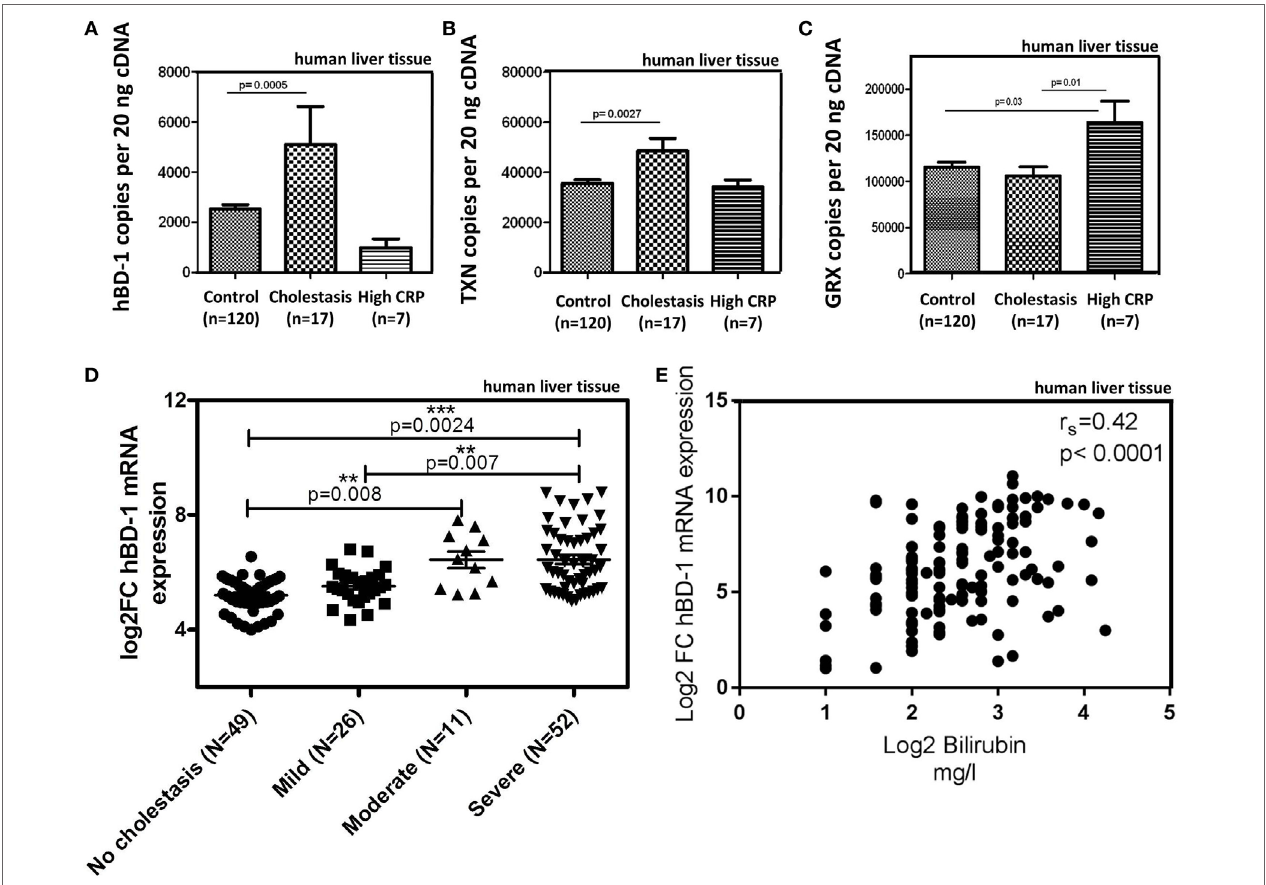
FigUre 3 | hBD-1 expression in samples of patients with cholestasis. (a–c) mRNA expression of hBD-1 (a) and human oxidoreductases TXN (B) and GRX (c) were analyzed in human liver tissue ( n = 144). Control group ( n = 120) without cholestasis was compared with cholestatic samples (serum bilirubin > 1.2 mg/dl, mean 4.5 mg/dl) and samples with signs of systemic inflammatory response (CRP > 5 mg/l). mRNA transcript levels are measured in an amount of 20 ng cDNA. Total copy numbers are depicted. Data are presented as means ± SEM. Values between groups were considered statistically significant with p < 0.05. (D) Hepatic hBD-1 mRNA expression was assessed in a cohort of patients with different grades of cholestasis ( n = 138). Depicted are scatter blots of individual hBD-1 expression with horizontal lines indicating medians. Data were analyzed by Mann–Whitney test. ** p < 0.01; *** p < 0.005. (e) Correlation matrix between mRNA expression of hBD-1 and bilirubin serum values. Spearman’s rank correlation coefficient is indicated as r s . Statistical significance for comparison was p <